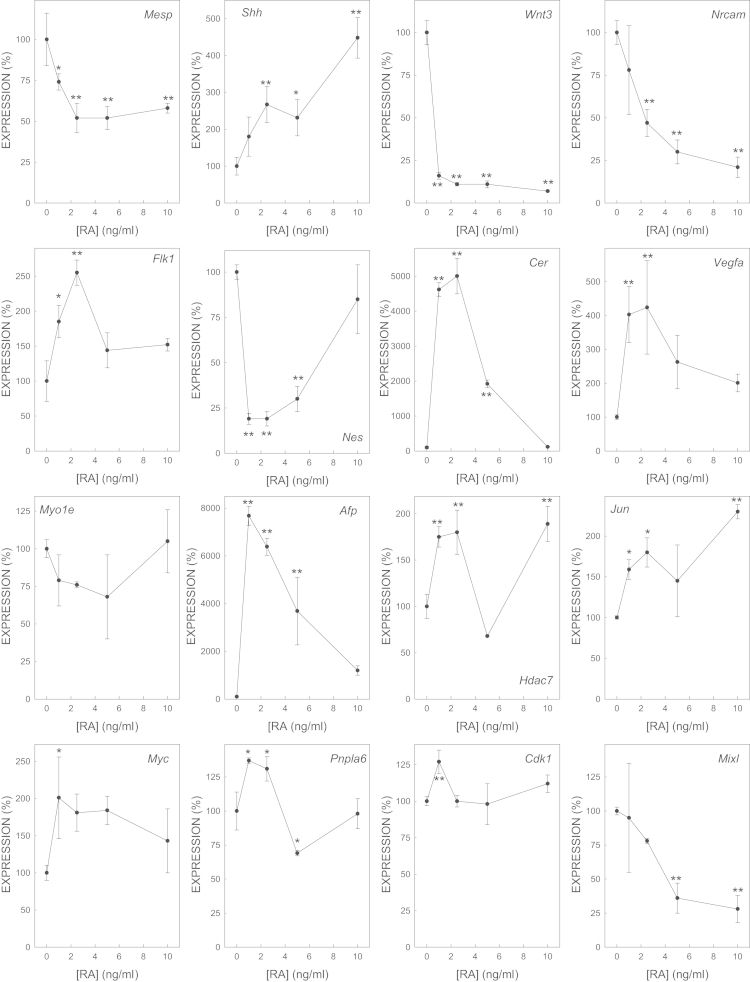
Effect of RA on the expression of biomarker genes.